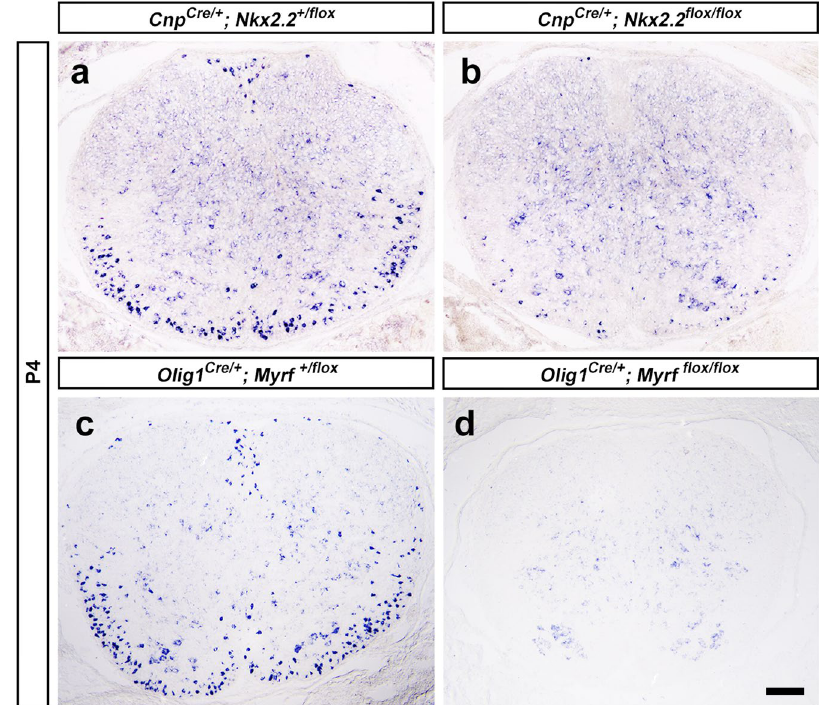
Figure 3. The numbers of Tmeff2 + cells are drastically reduced in Nkx2 . 2 and Myrf CKO mice. ( a–d ) Compared with wild type mice ( a,c ), the numbers of Tmeff2 + cells are reduced in Nkx2 . 2 -CKO mice ( b ) and completely lost in Myrf -CKO mice ( d ) at P3 stage. Bar, 100 μ